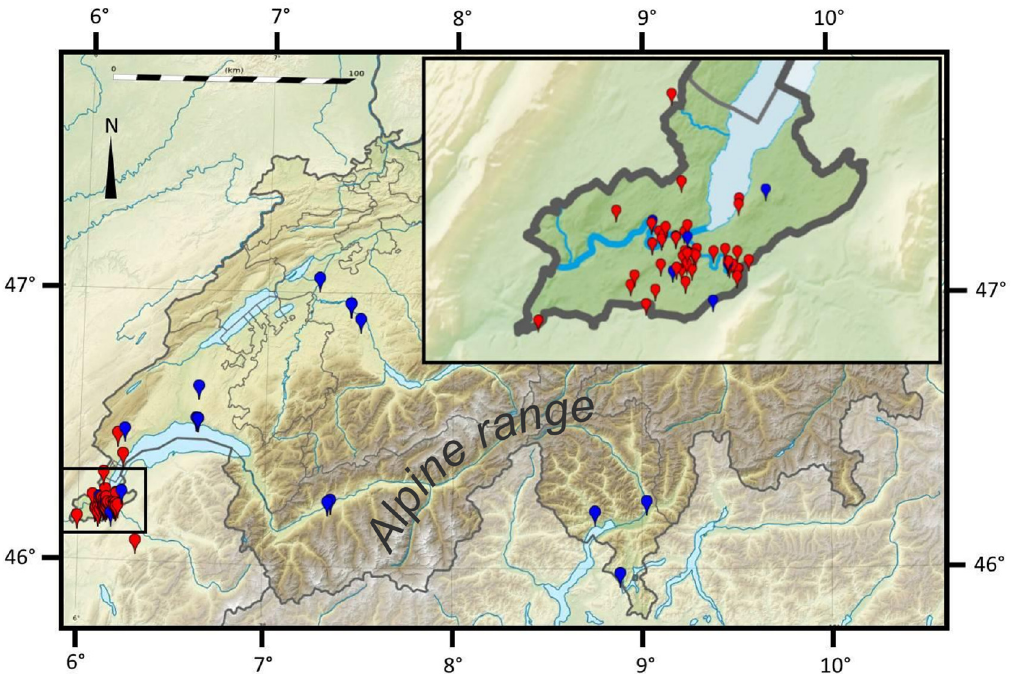
Fig 2. Sampling localities of P . kuhlii within Switzerland and neighbouring France. The inset provides a detailed map for the Geneva province. The sampling includes 79 specimens whose precise geolocation was available. Each individual is pictured as a dot, coloured in red or in blue depending on whether it belongs to the Western or to the Eastern mitochondrial lineage,